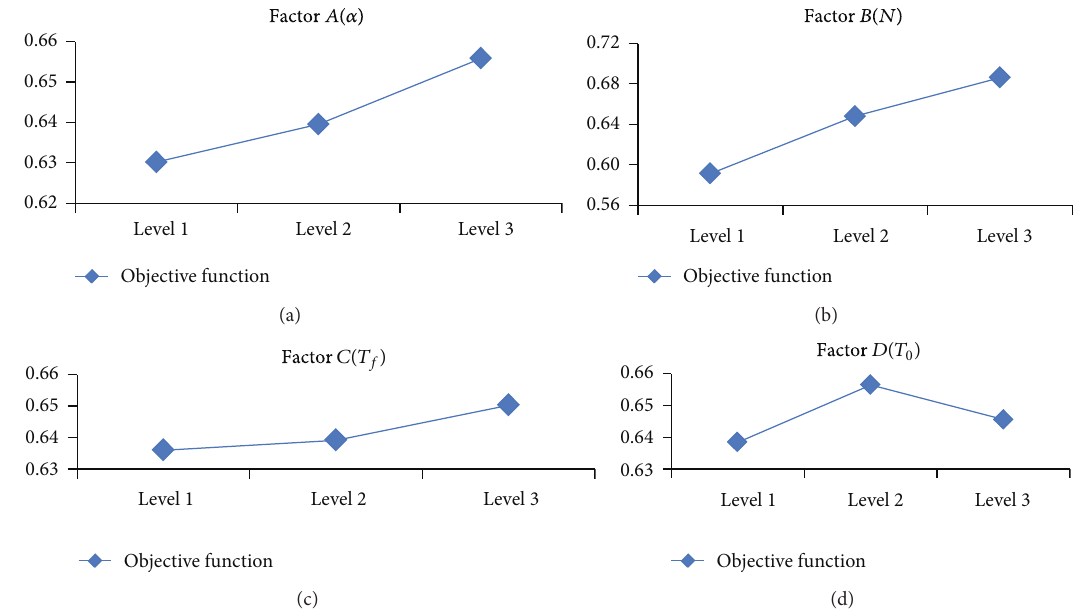
Figure 6: Diagram of mean effect of parameters based on the objective function for small problem in genetic algorithm.